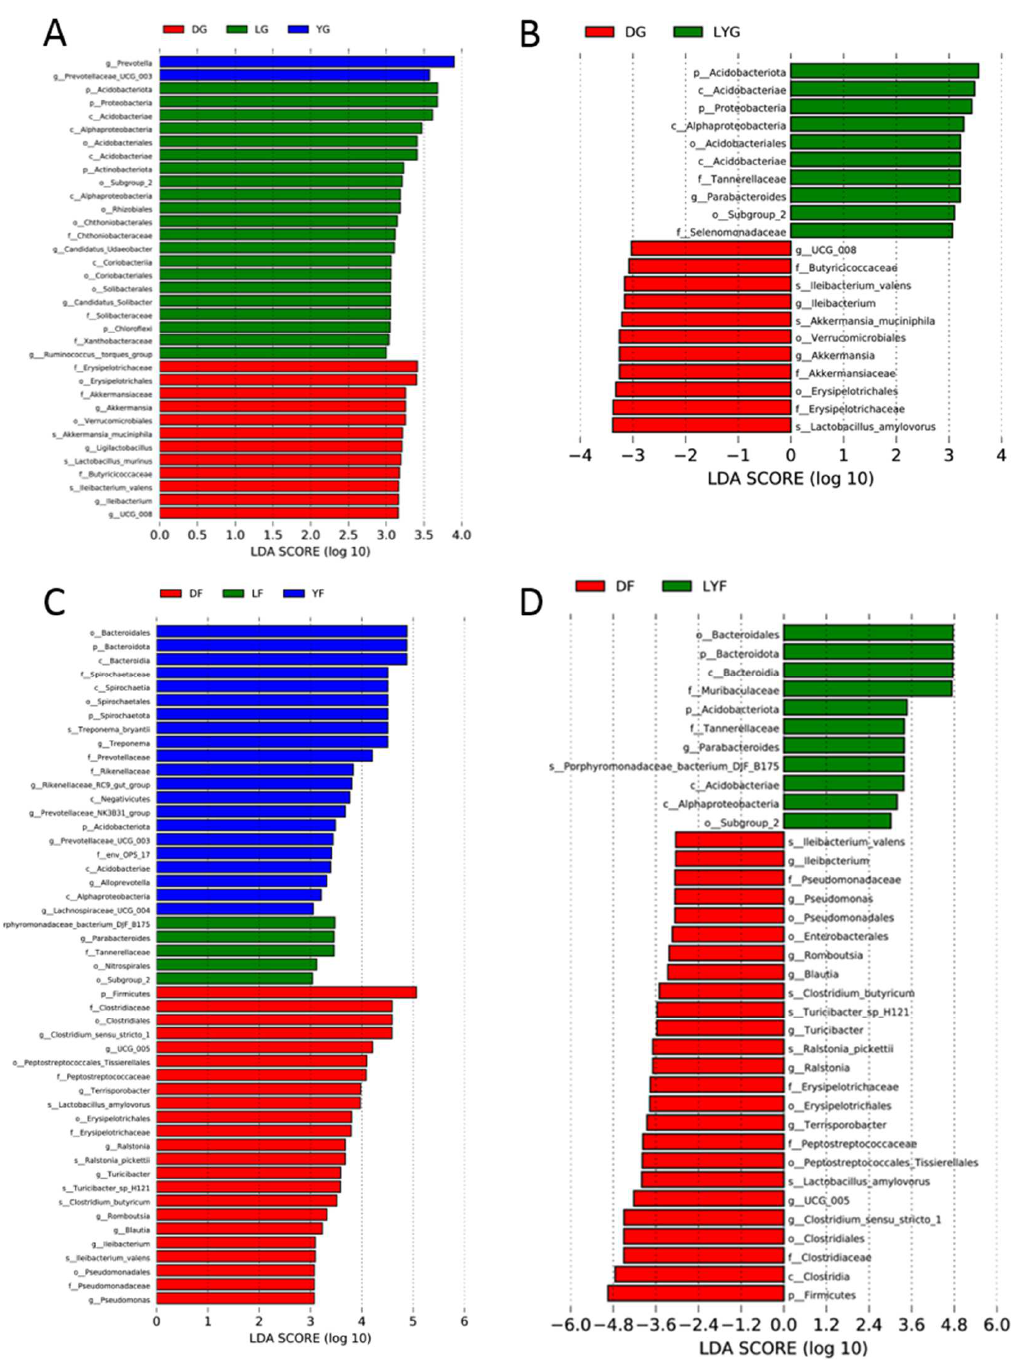
Figure 5. Differences in the gut microbiota composition of different pig breeds at early and finishing growth stages based on Linear discriminant analysis effect size (LEfSe). ( A ) Differential microbial species in the gut microbiota of Duroc, Landrace and Yorkshire pigs at the early growth stage. ( B ) Differential microbial species in the gut microbiota of Duroc, Landrace and Yorkshire pigs at the finishing stage. ( C ) Comparison between the gut microbiota composition in pigs of Duroc and the Landrace and Yorkshire (LY) breeds at the early growth stage. ( D ) Comparison between the gut microbiota composition in pigs of Duroc and LY at the finishing stage.